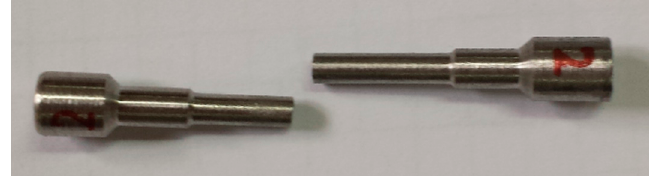
Figure 9. Sample THA-2 with THA-3 fractured in the joint line or in its immediate vicinity.